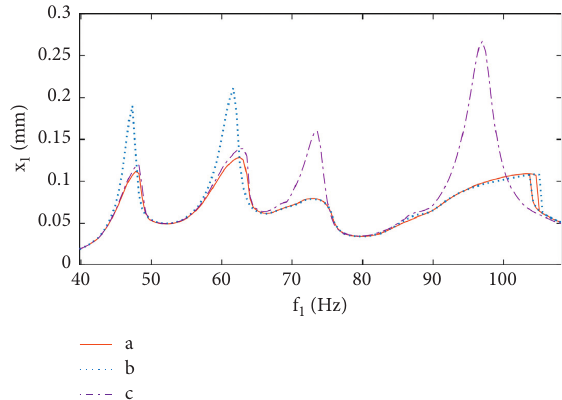
Figure 13: Comparisons of different SFD implemental configu- rations (a: two SFDs, b: one front low-pressure SFD, c: one rear low-pressure SFD).